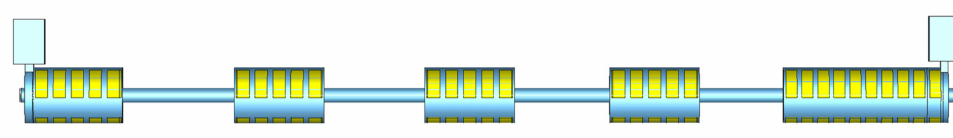
Figure 6. 3D PIC simulation model of the complete circuit.